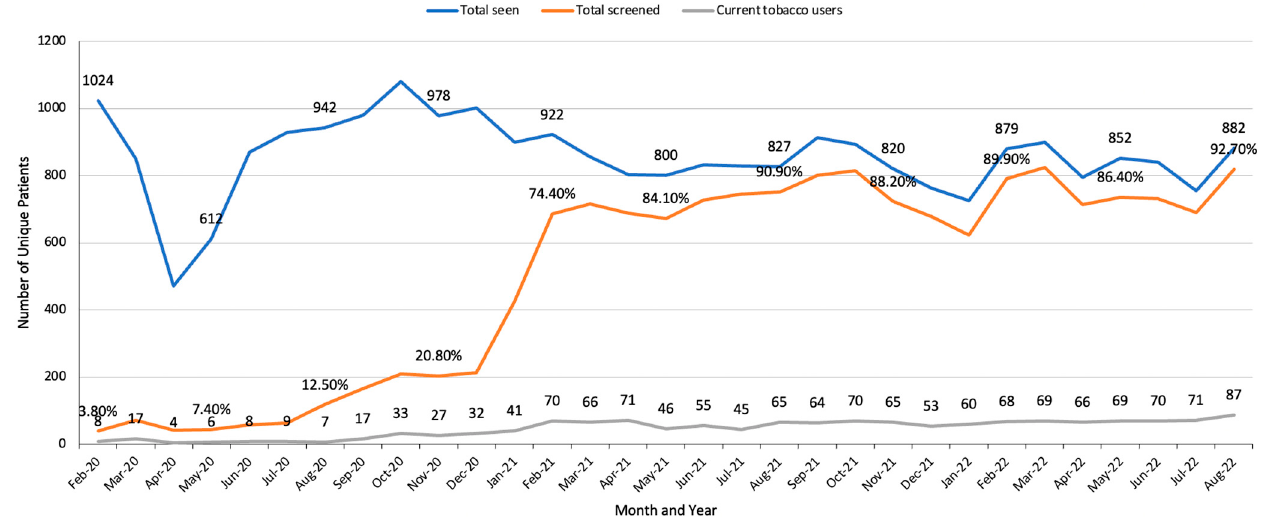
Figure 4. MWHC monthly assessment of the number of unique patients seen in hematolo- gy/oncology clinics, percentage of patients screened for tobacco use, and the number of identified tobacco users. Note: patients attending telehealth and lab visits were excluded from this analysis, as MAs were not involved in these visits.